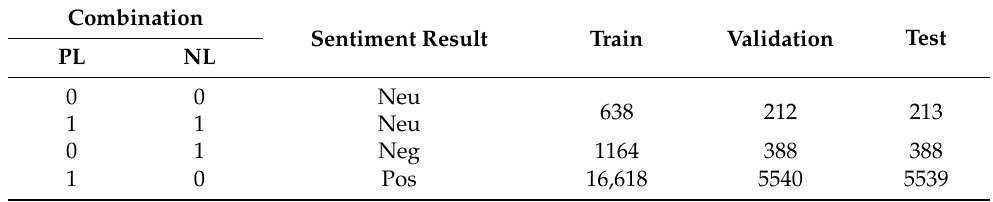
Table 1. SenTARev’s Label Distribution.